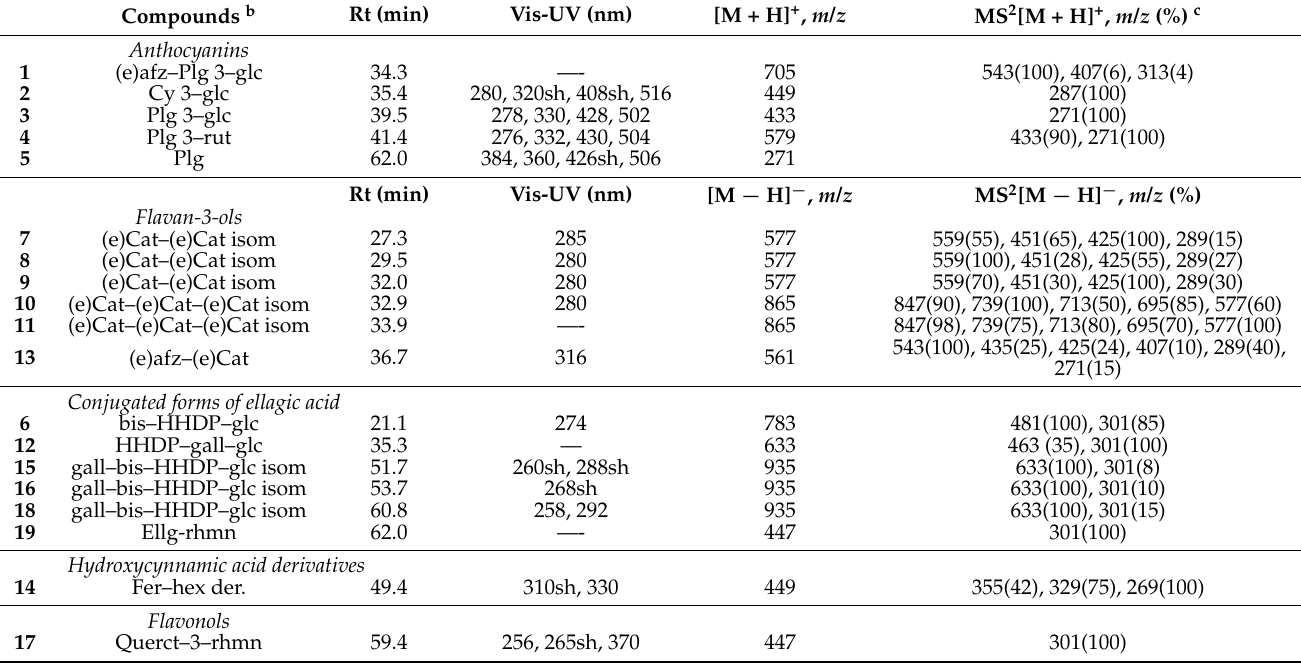
Table 2. Identification of phenolic compounds of hydroalcoholic extract from strawberry fruits a using HPLC-DAD-ESI-MS n . Compounds